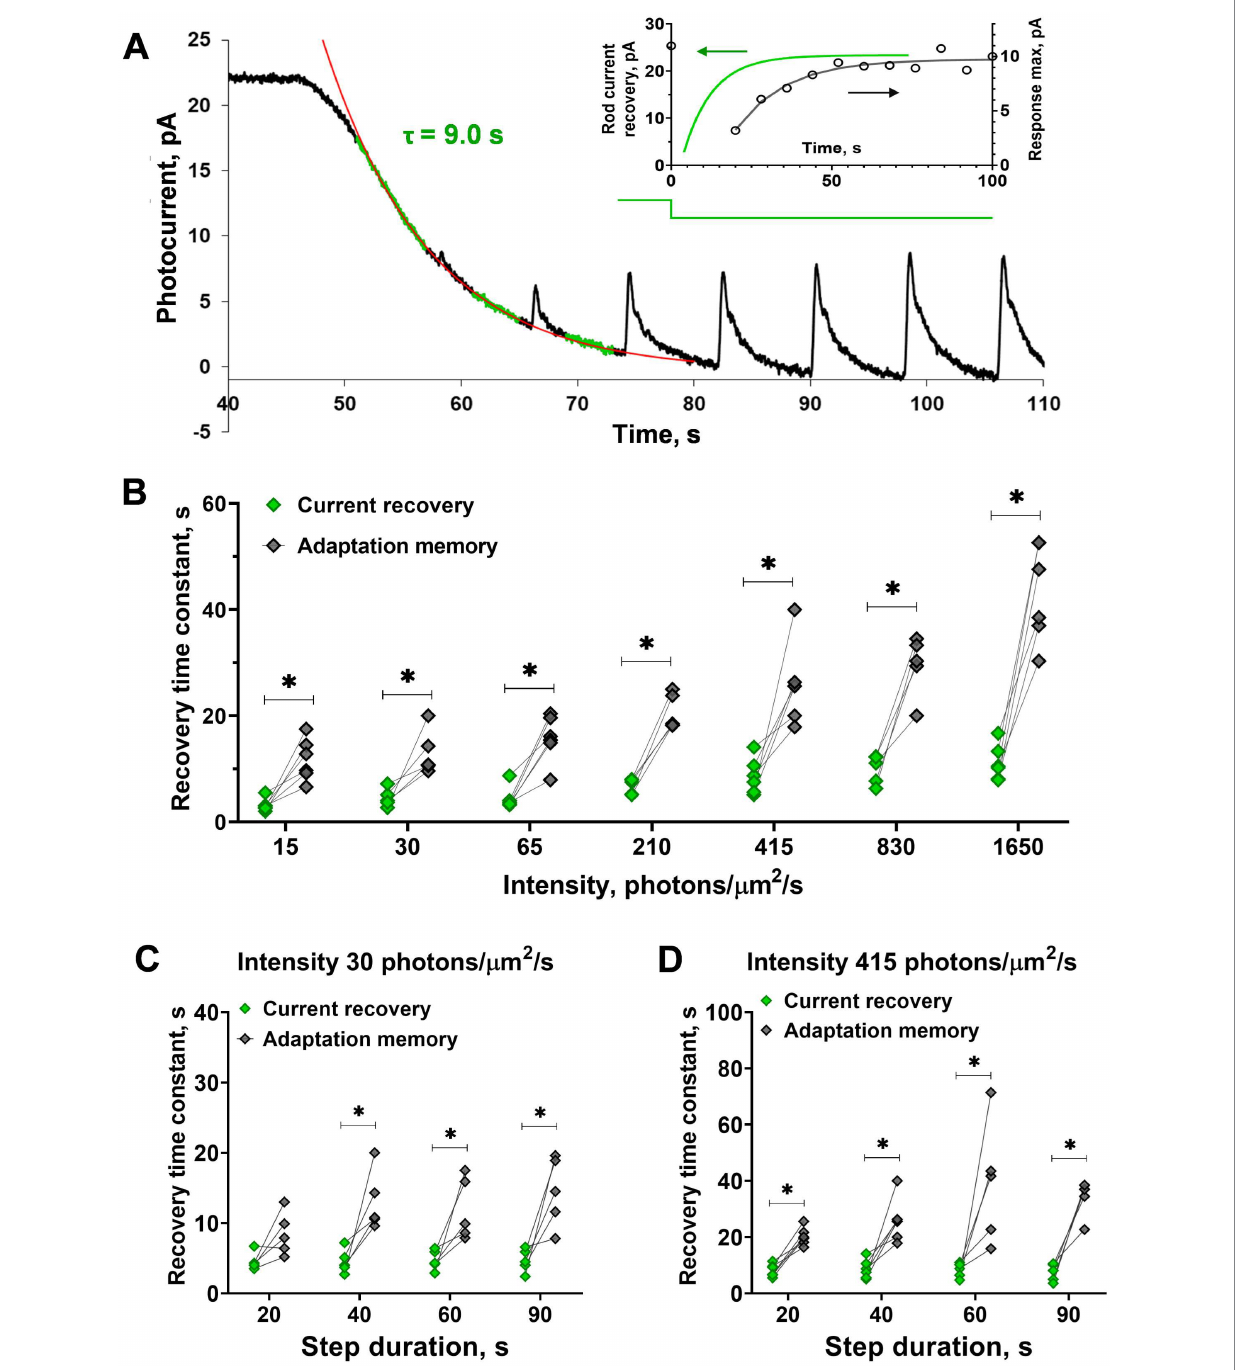
FIGURE 2 Comparison of the current recovery rate and recovery of sensitivity (‘adaptation memory’) after steps of increasing intensity and duration. (A) Evaluation of the current recovery rate with an exponential function. Several fragments between responses to the brief stimuli of the current record were used for approximation (shown by the green noisy line). The red solid line is an exponential fitting for the current recovery phase. Inset shows the time courses of current and rod sensitivity recovery for this cell. The difference in the recovery rates are significant under adaptive illuminations of different intensities (B) and durations (C,D) except for the one case of a short, low-intensity step. Asterisk * indicates statistically significant differences between groups (paired t -test; p < 0.05). Sample sizes n =